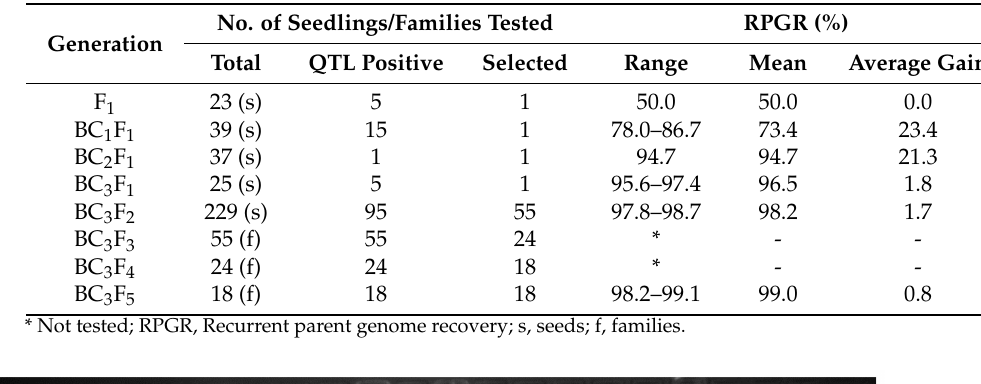
Table 2. Progressive selection statistics for the development of PB1 near isogenic lines introgressed with the reproductive stage drought stress (RSDS) tolerance QTL, qDTY1.1 .